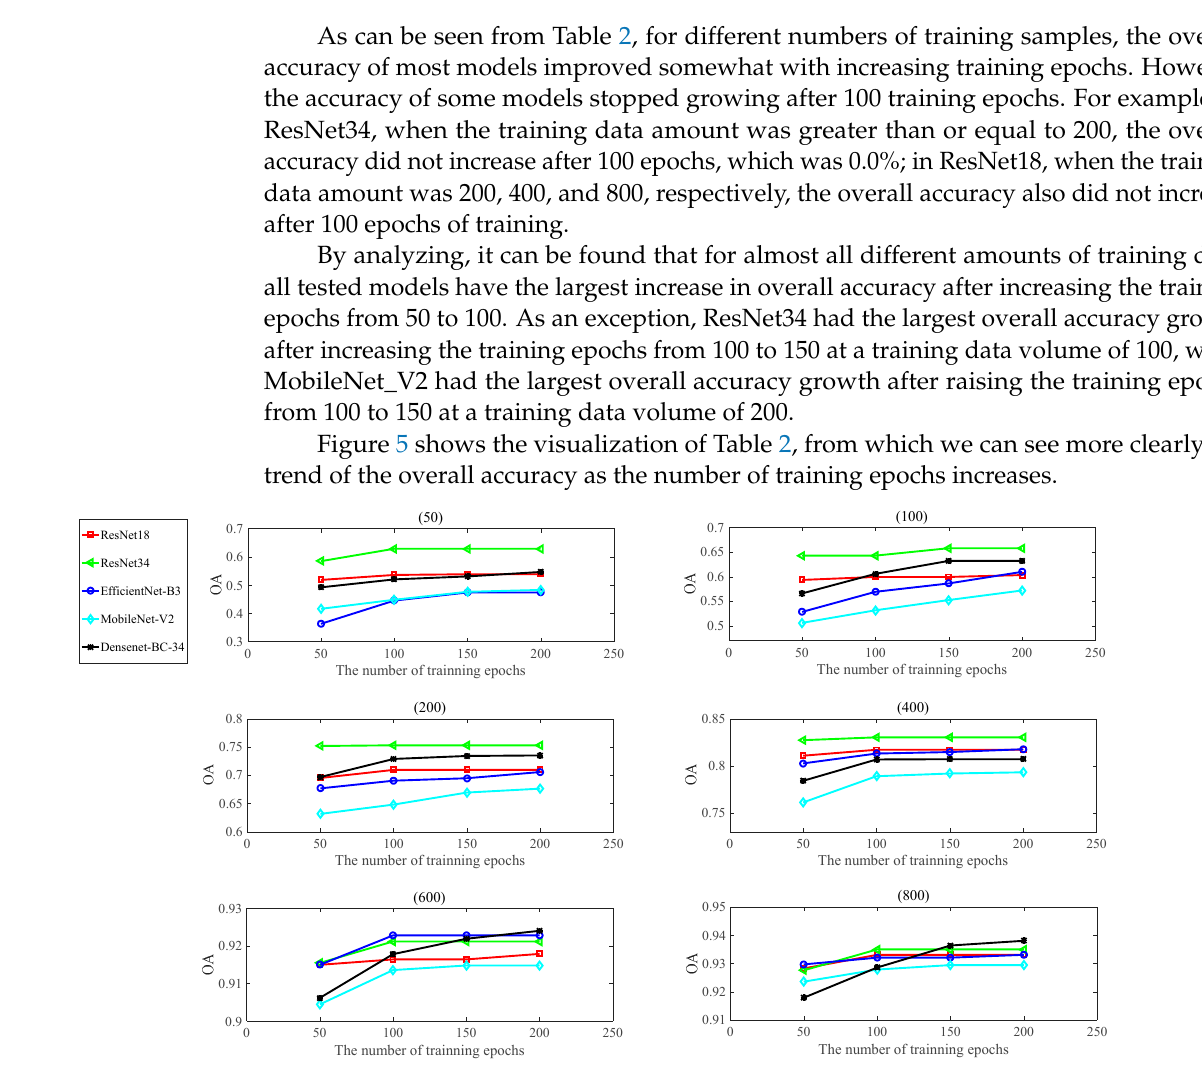
Figure 5. Trend of the overall accuracy of the model with different training epochs.